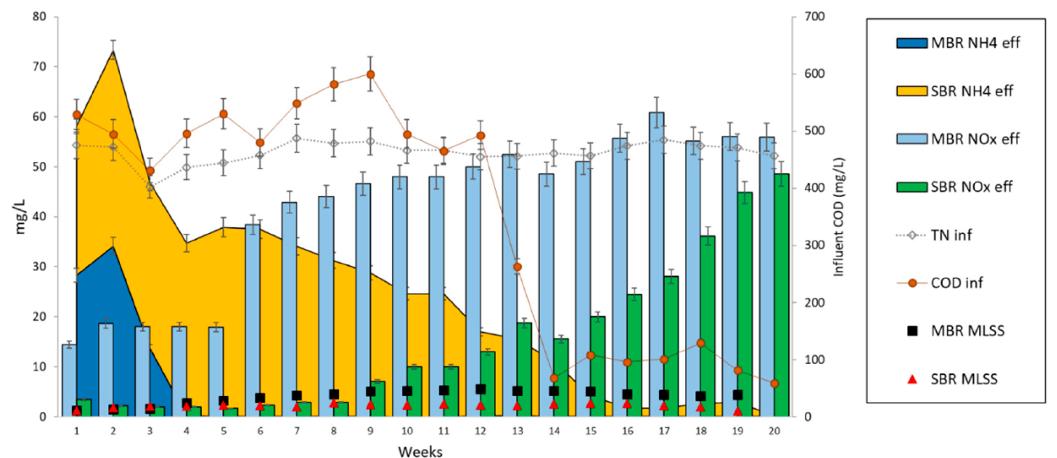
Figure 5. Ammonium oxidizing efficiency during the experimental period. The results presented as average value between the two reactors. The error bars represent standard errors. Wastewater composition is changed during Weeks 12–14.